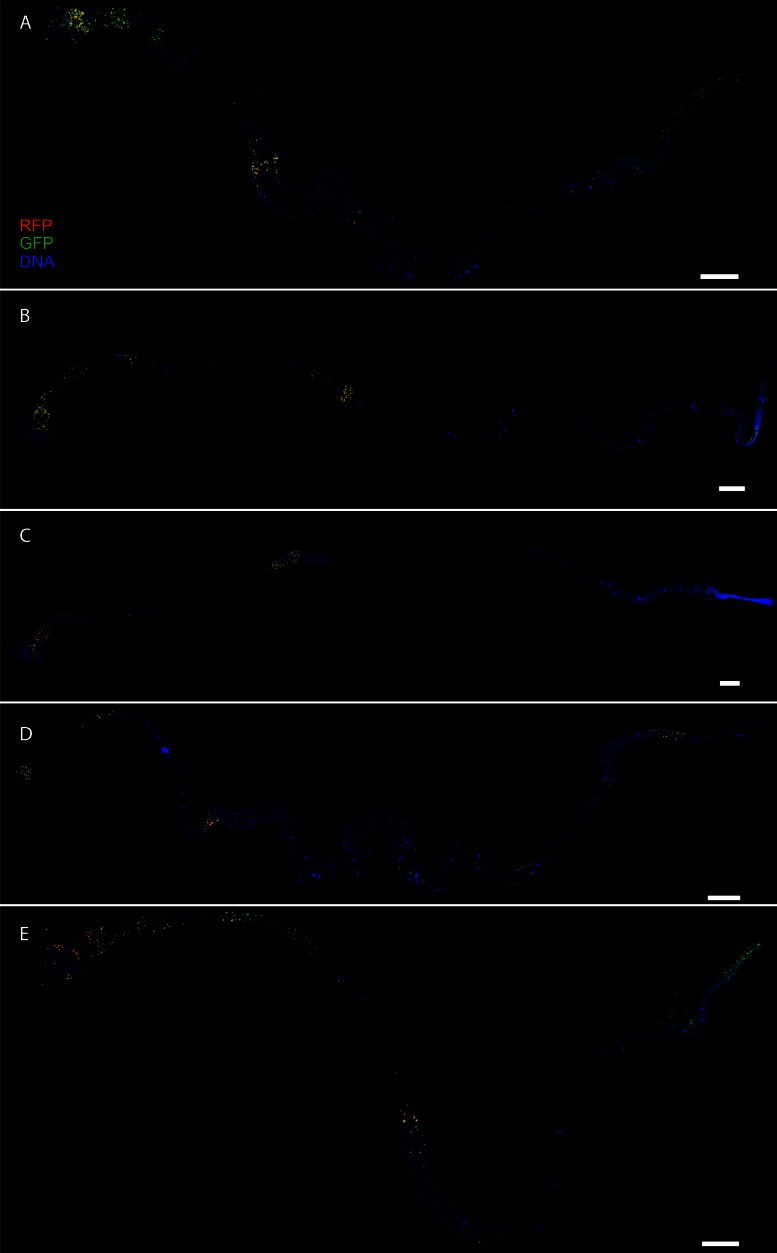
CasExpress patterns in larval intestines.(A–E) Five different examples of RFP and GFP expression patterns in larval intestines. DAPI is shown in blue. All scale bars are 400 μm.